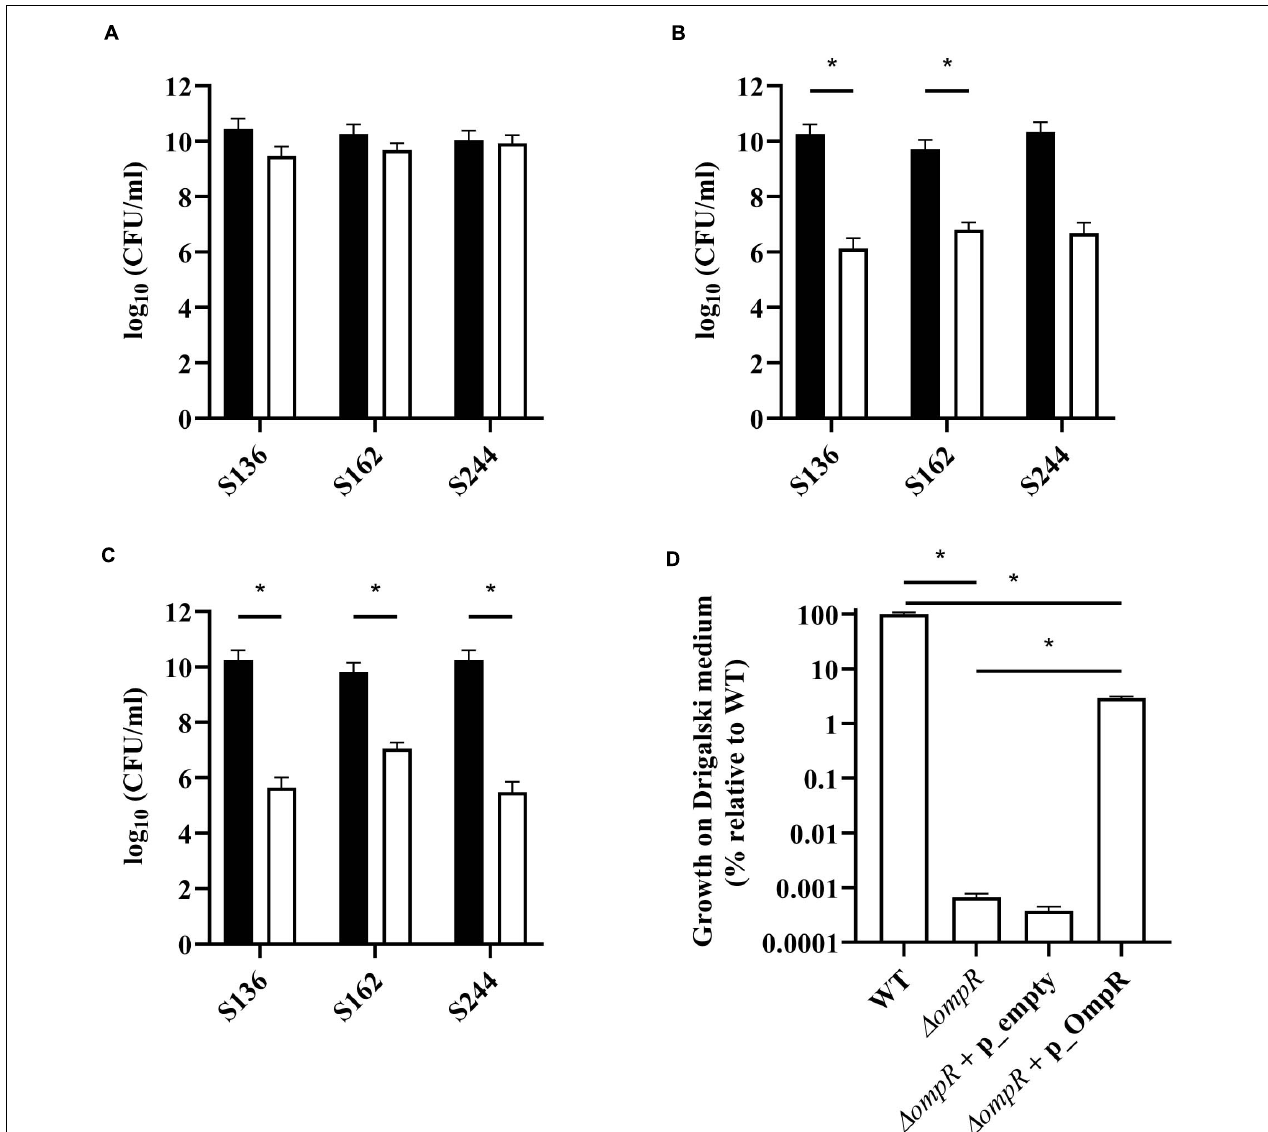
FIGURE 3 | Quantification of AIEC WT and (cid:49) ompR mutants in different agar media. WT (black bars) and (cid:49) ompR (white bars) AIEC strains were inoculated on (A) LB, (B) MacConkey, and (C) Drigalski agar media and the CFU/ml were determined after overnight growth at 37 ◦ C (means ± SEM, 2 independent experiments). (D) The WT AIEC S244 strain and its respective (cid:49) ompR mutant complemented with an empty plasmid ( (cid:49) ompR + p_empty) or a plasmid expressing OmpR ( (cid:49) ompR + p_OmpR) were inoculated on Drigalski agar and the CFU/ml were determined after overnight growth at 37 ◦ C (means ± SEM, 3 technical replicates). * p < 0.05, unpaired t